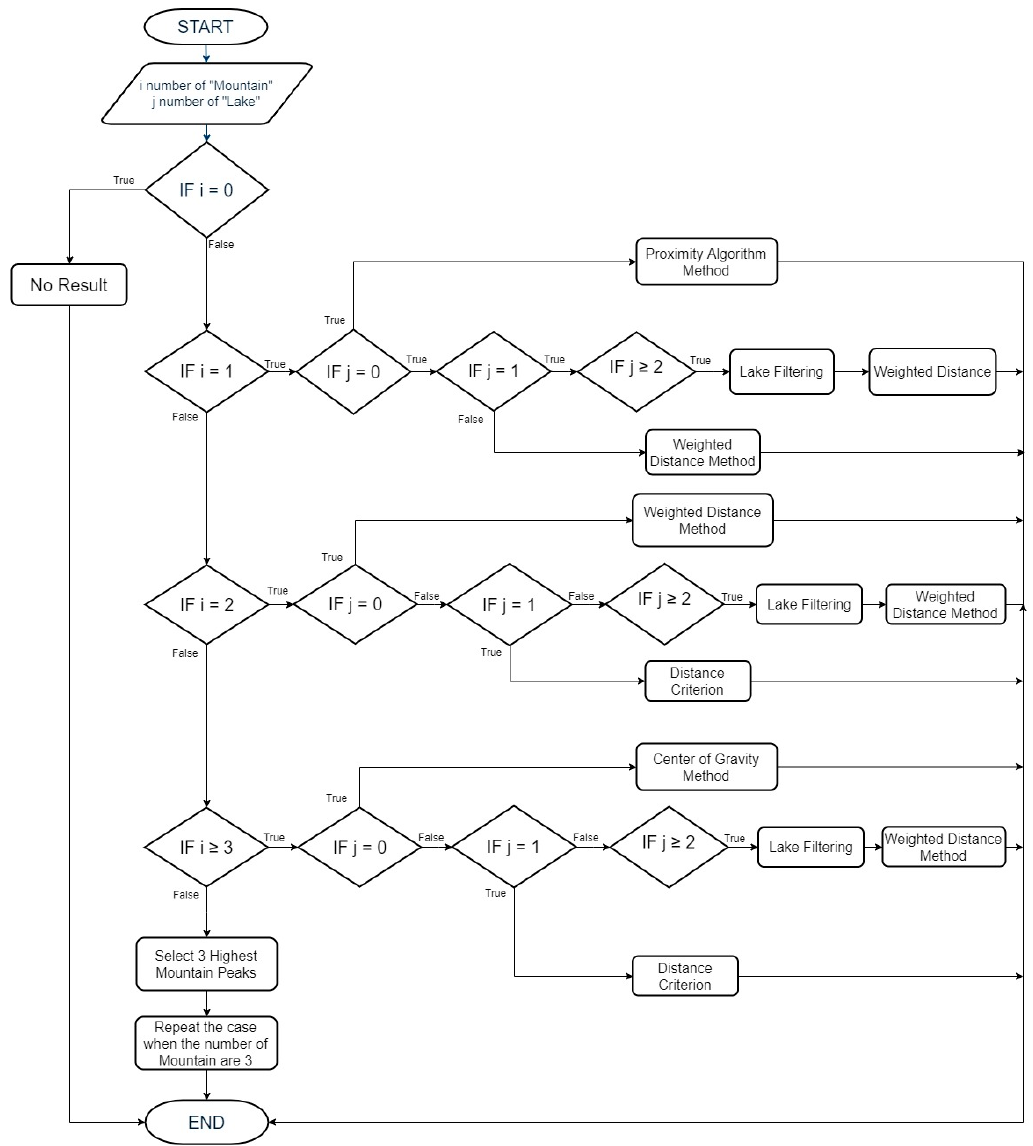
Figure 21. Flowchart of the positioning algorithm.